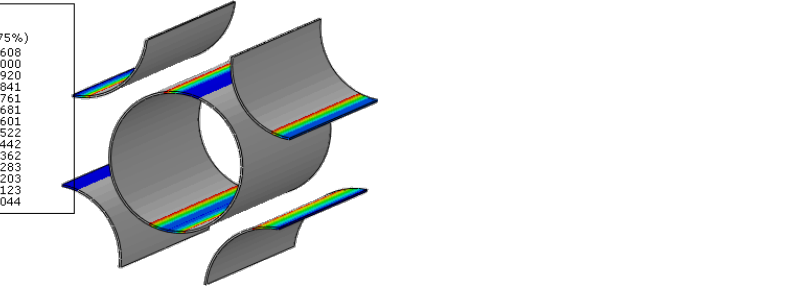
Figure 20. Damage propagation in the interface of fiber diamond distribution model.